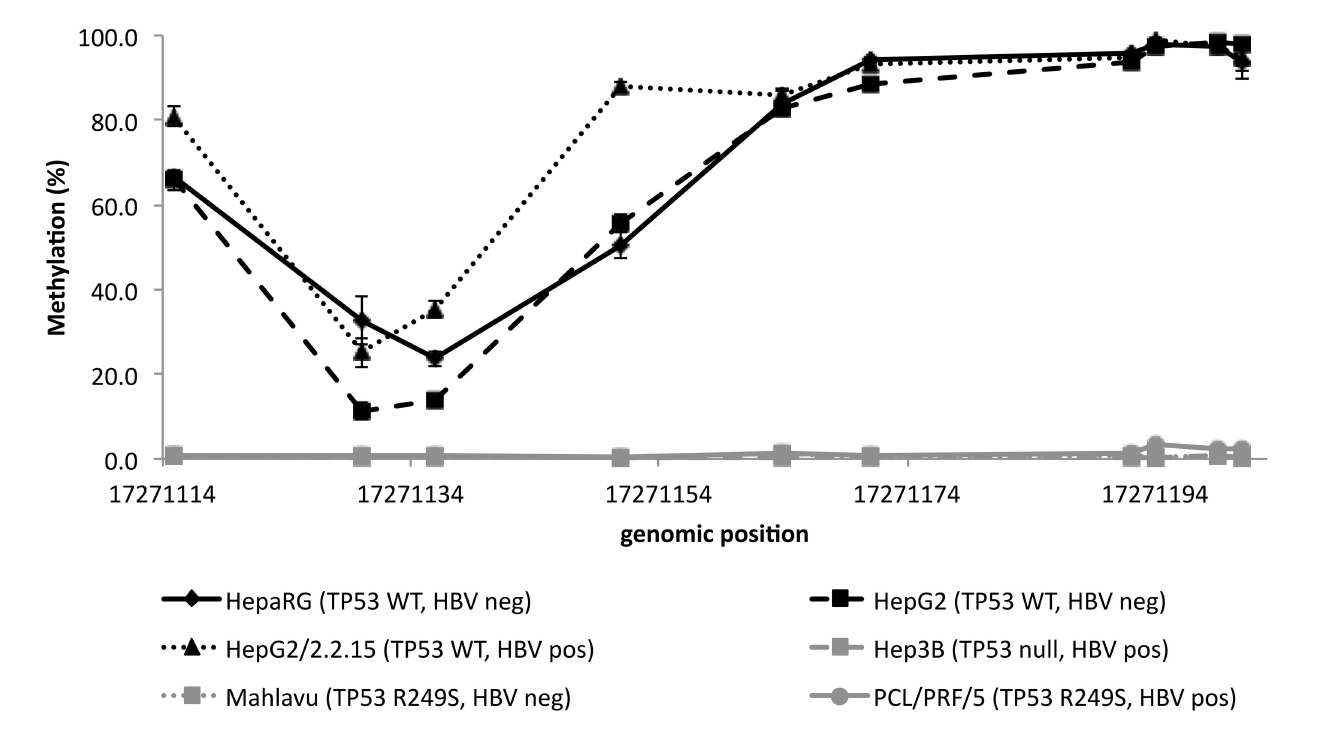
Fig 5. VIM methylation in liver cell lines with different TP53 mutation and HBV–status. WT = wild type, R249S = missensemutation in the codon 249 of TP53.